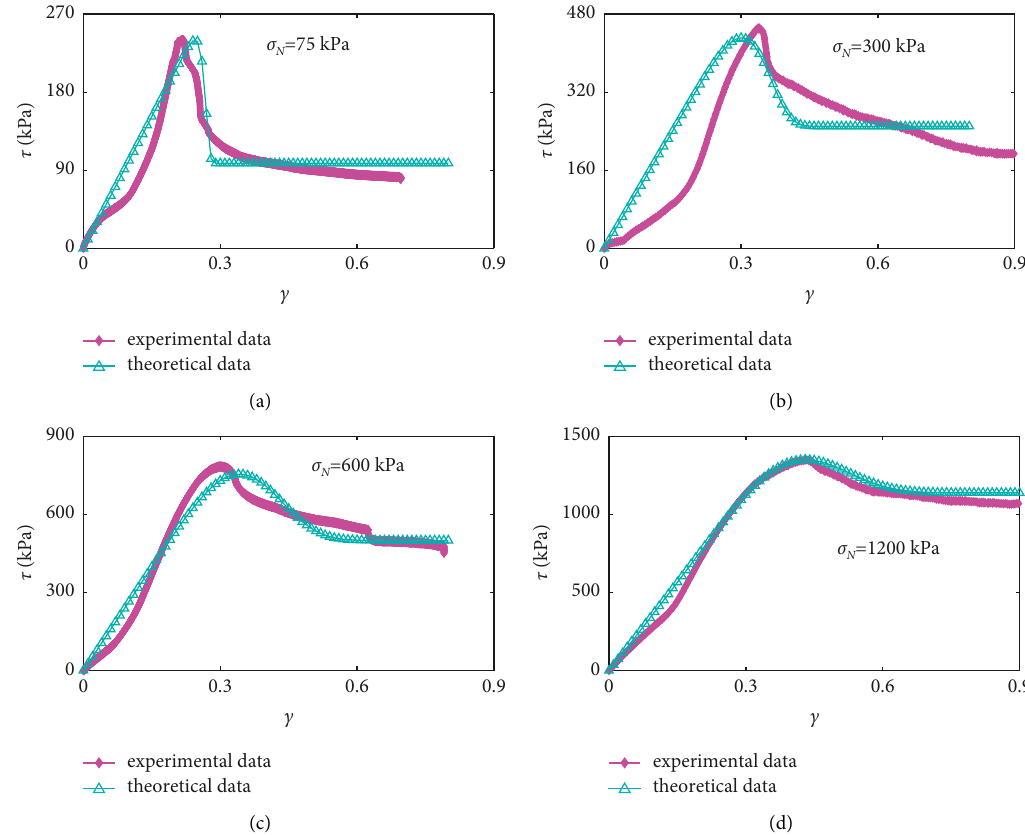
Figure 6: Comparison between the experimental and theoretical τ - c curves of the TFPU-bentonite contact surface under different σ